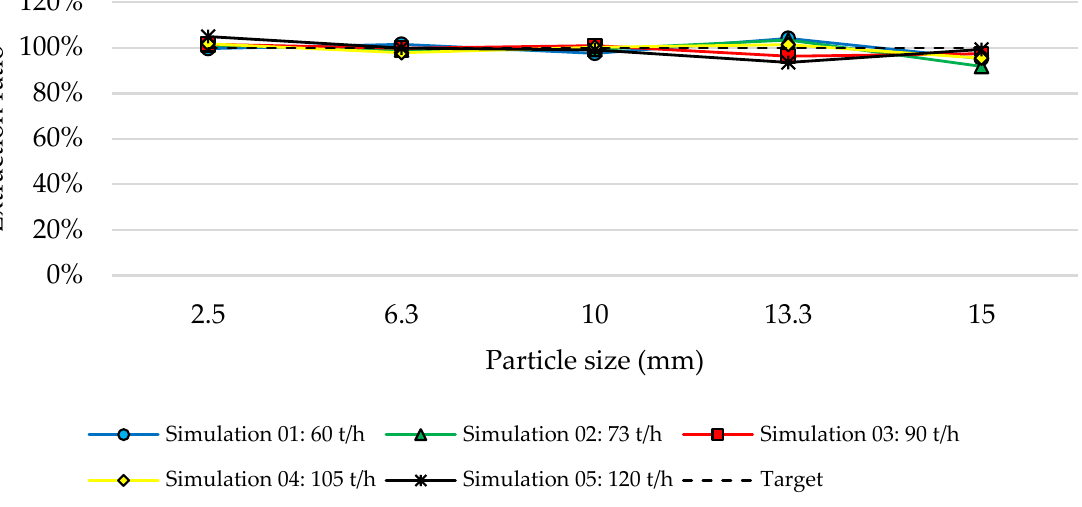
Figure 14. Extraction in cross-stream cutter as function of solids feed rate.